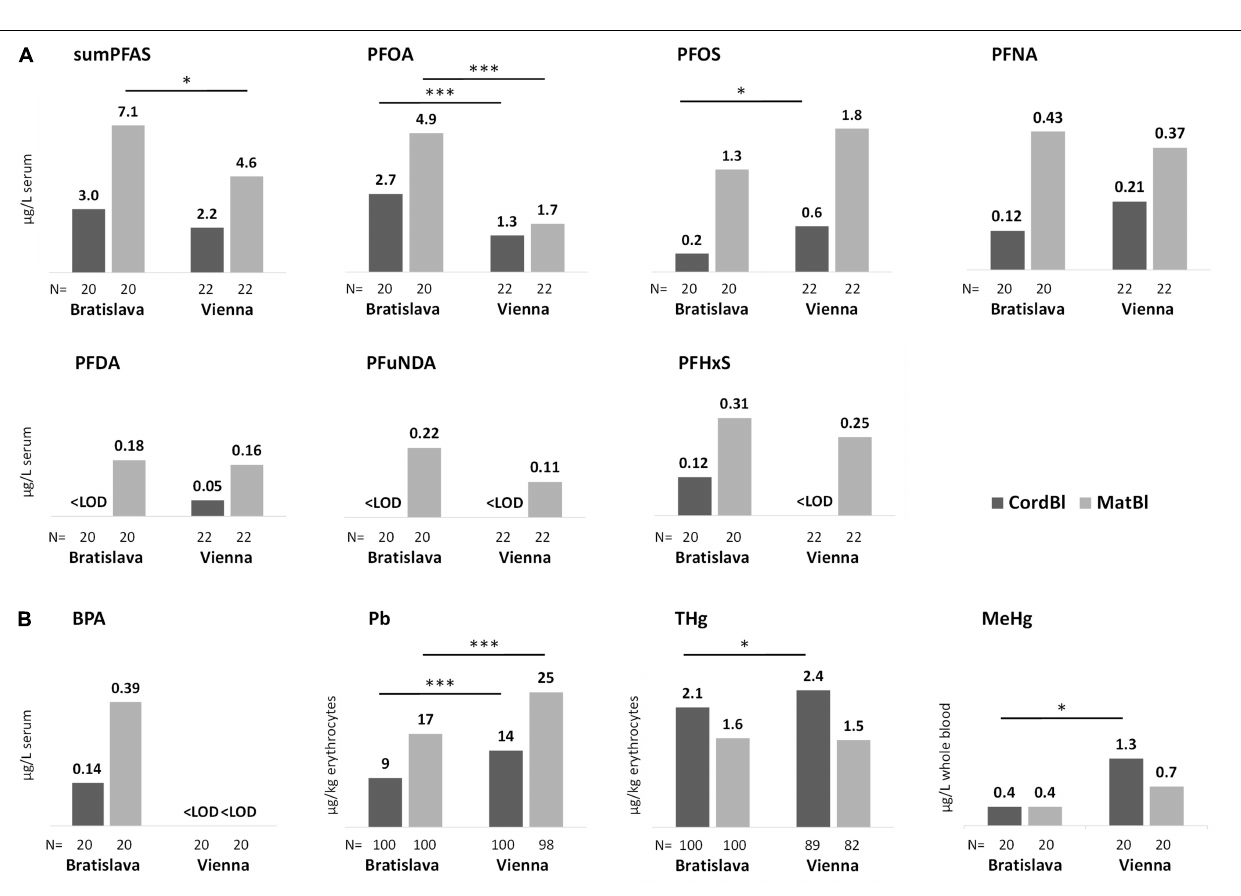
FIGURE 2 | Median levels of (A) PFAS and (B) BPA, Pb, THg and MeHg in cord blood and maternal blood specimens. Site-specific differences are marked with asterisks. Kruskal Wallis-test * P < 0.05 and *** P <